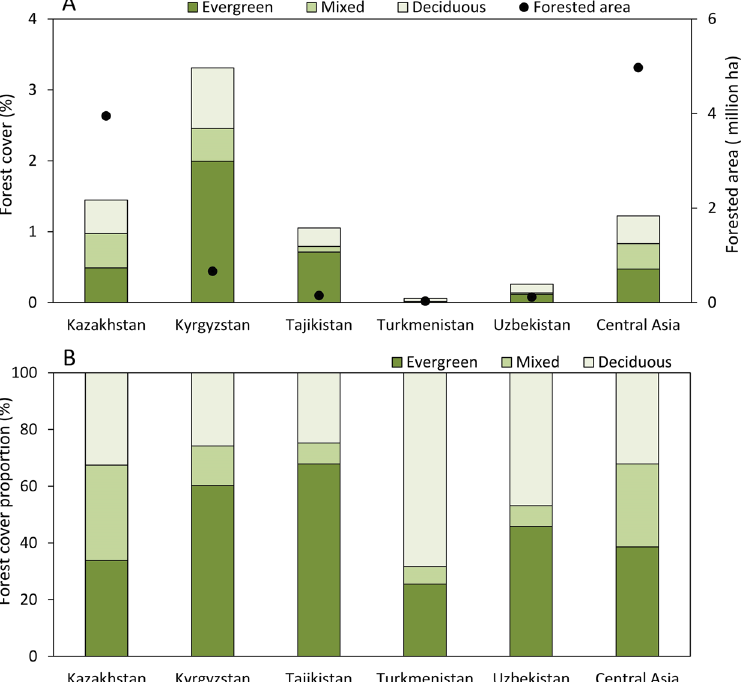
Figure 1. Land area covered by forests ( A ) and the composition of forest types ( B ) in Central Asia.